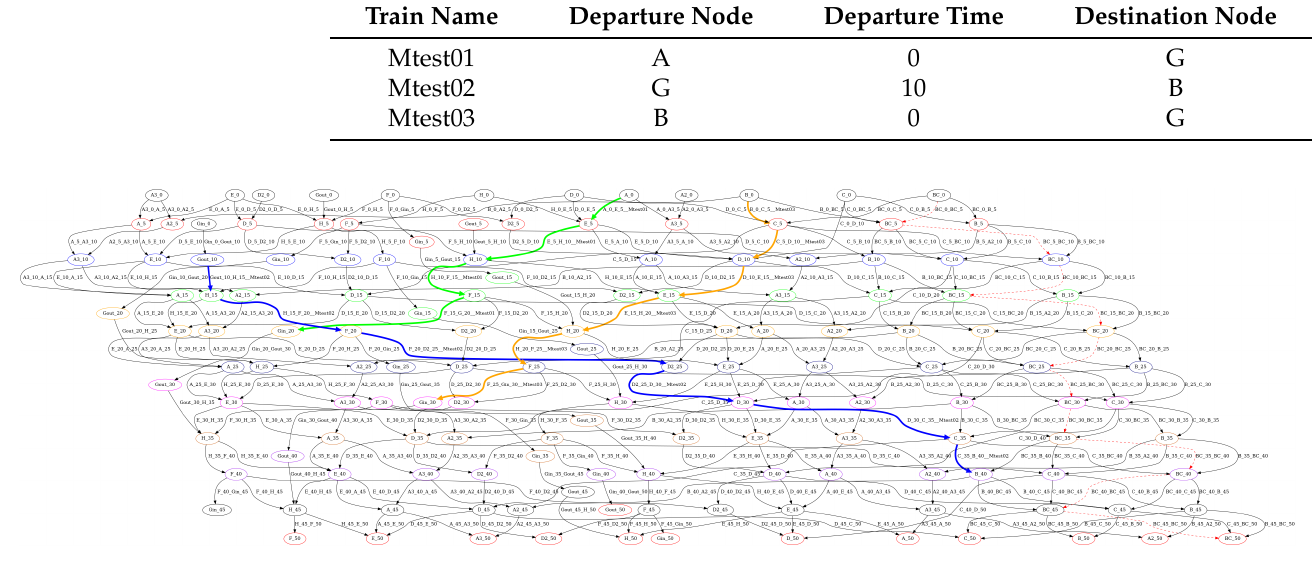
Figure 10. Case 3: Train schedule. Table 6. Case 3: Train schedule.